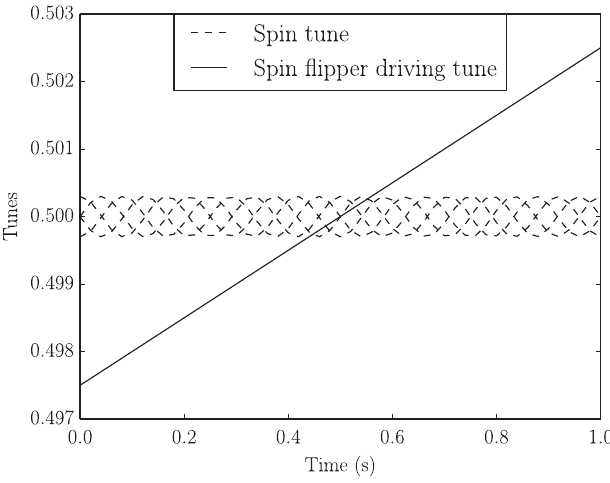
FIG. 1. Mechanism of multiple spin tune crossings by the spin flipper driving tune at injection energy. The spin tunes for off- energy particles (dashed curves for three different phases) oscillate with the synchrotron frequency ( ∼ 6 Hz). The spin flipper tune (the solid line) is ramped across the design spin ¼ 1 = 2 ) and intersects the spin tune of some of the tune ( ν sp particles multiple